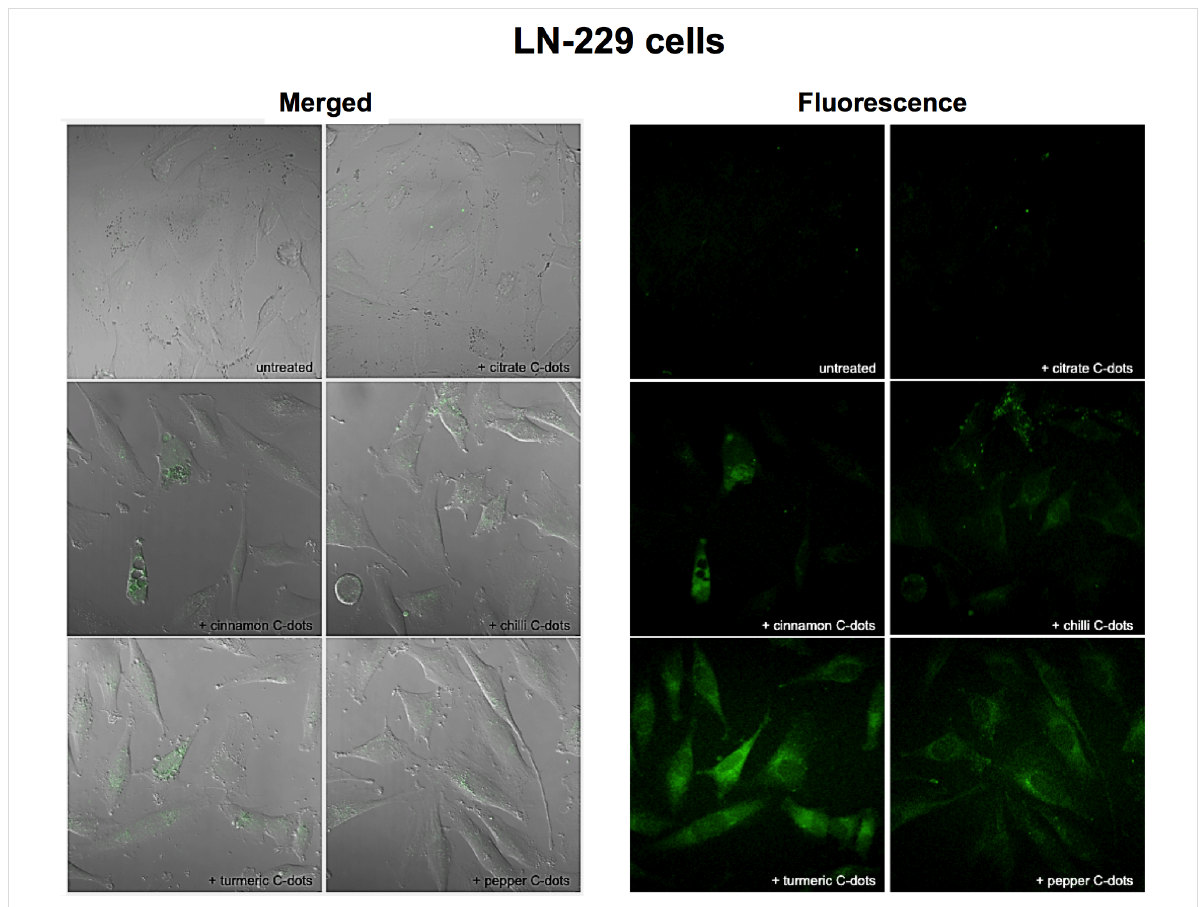
Figure 9: Merged transmission and fluorescence (left) and fluorescence (right) imaging of LN-229 cancer cells after 24 h of incubation with no C-dots (untreated) and with 1 mg·mL − 1 of citrate, cinnamon, red chilli, turmeric and black pepper C-dots. Images were collected using a Zeiss LSM780 confocal microscope (40× objective), using a 405 nm laser and collecting the emitted fluorescence in the green